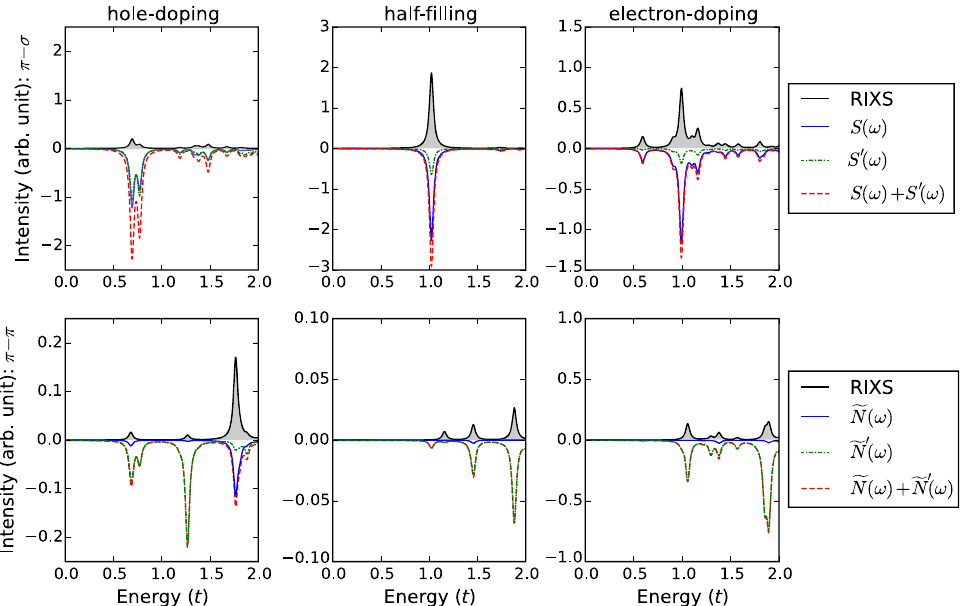
FIG. 5. Cross sections at the q ¼ ð π = 2 ; π = 2 Þ point with the elastic response removed. Top (bottom) panels show spectra for the π - σ ( π - π ) polarization. Left, middle, and right panels show RIXS spectra calculated for n ¼ 0 . 83 , n ¼ 1 , and n ¼ 1 . 17 electron fillings, respectively. The approximate spectra are weighted with the RIXS form factors, i.e., S ð q ; ω Þ → j W π ~ ~ N N 0 ð q ; ω Þ ð q ; ω Þ and similarly for S 0 ð q ; ω Þ and j W π - π j 2